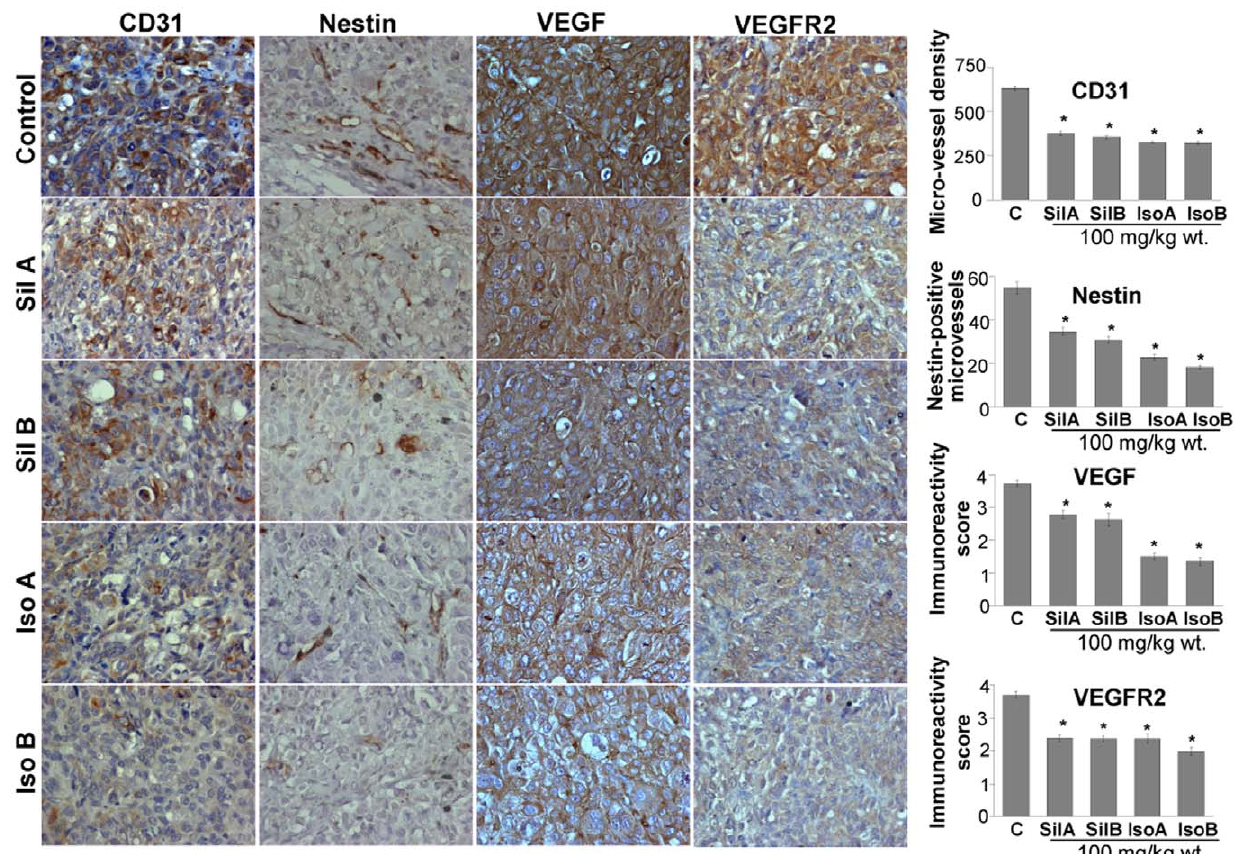
Figure 2. Flavonolignans inhibit angiogenesis invivo . DU145 xenograft tissues were analyzed for CD31, nestin, VEGF and VEGFR2 by IHC. Quantitative analyses were performed using Zeiss Axioscope 2 microscope (Carl Zeiss, Germany) and photographs were originally captured (at